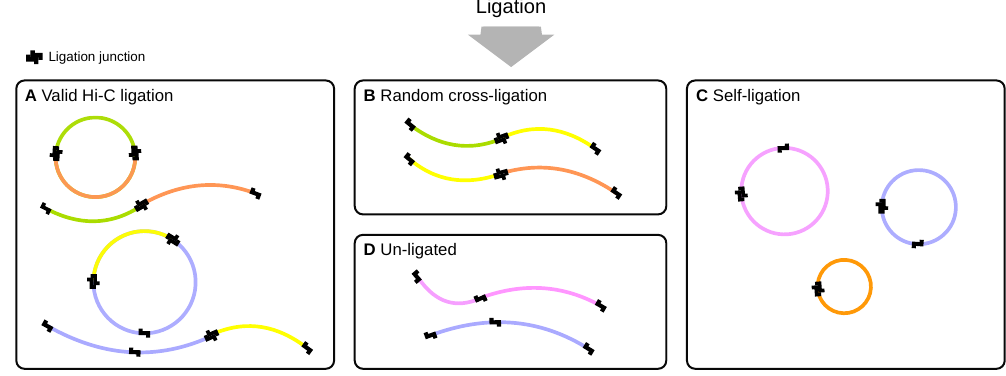
Figure 2. Ligation between digests within the same cross-linked protein-DNA complex results in intended chimeric Hi-C products that consist of digest pairs linked by ligation junctions. Given pairs may form circular or linear molecules ( A ). Beyond that, the ends of digests from different protein-DNA complexes may also ligate, which is referred to as random cross-ligation. Those unintentional ligations lead to false positive predicted interactions ( B ). Furthermore, the ends of individual digests may ligate, which results in circular molecules and is referred to as self-ligation ( C ). Finally, the ends of given digests may remain un-ligated ( D